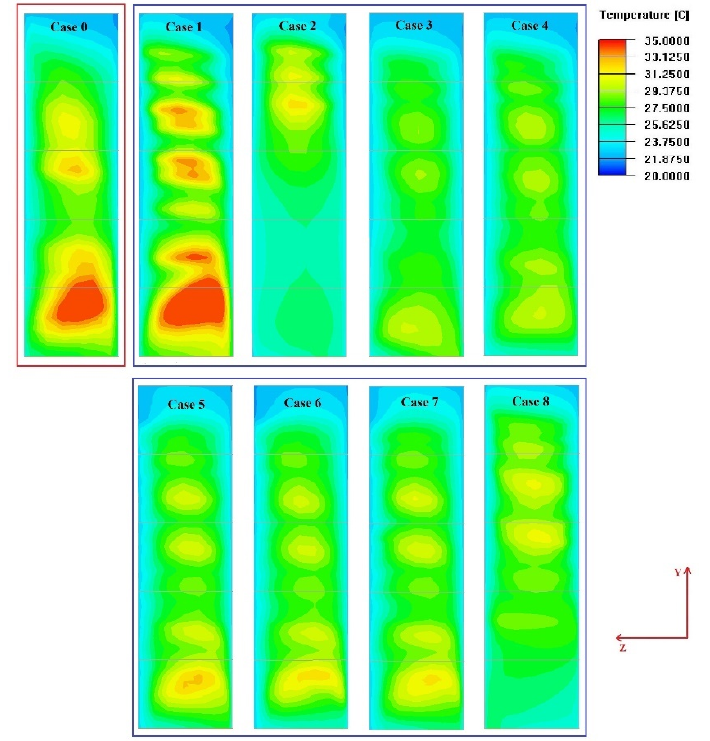
Figure 12. The heat distribution profiles of the air outlet of the rack B4 in the cases 0–8 . Figure 13 shows the change in the average temperature of air outlet in cases 0–8. In case 0, the average temperature of the back door of rack B4 is 28.4 °C. In case 1, the HPEs are installed close to the top of the server, which increases the average air temperature of the back door Teva, bac to 28.9 °C. By adjusting the different installation heights, we found that, in case 2, the mean temperature of the back door is significantly reduced to 26.6 °C. When the installation height continues to increase from 0.5 cm to 3.5 cm, the mean temperature of the back door of the rack B4 rises slightly, but it still maintains lower the mean temperature than with case 0.